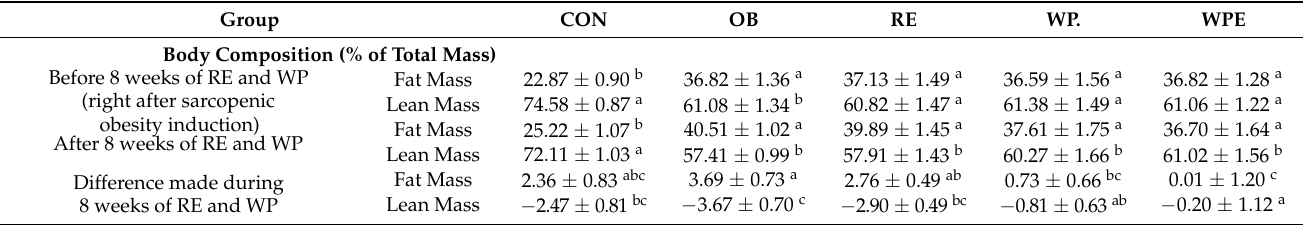
Table 2. Effects of WP supplementation and RE on the diet intake, body, fat, and muscle weights, body composition, and muscle strength in sarcopenic obese